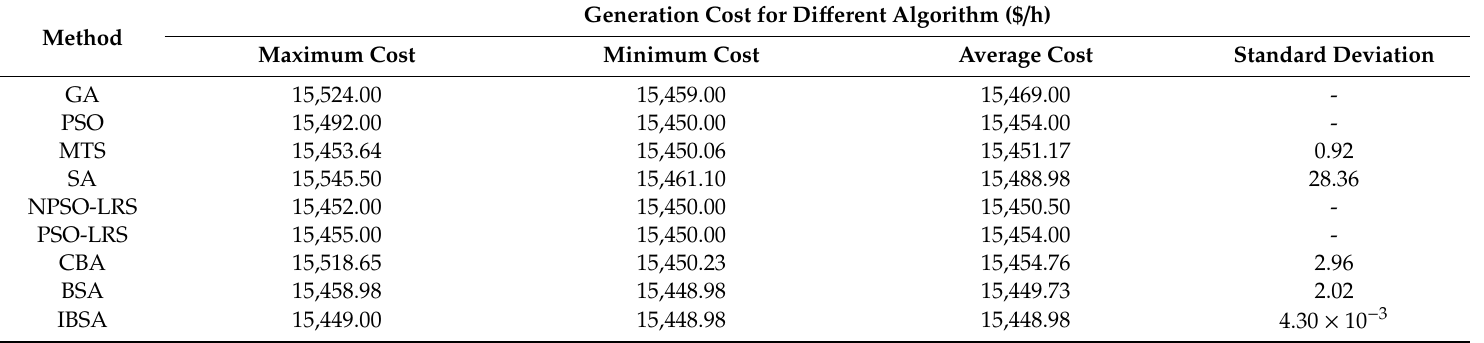
Table 6. Statistical results of multiple methods in System